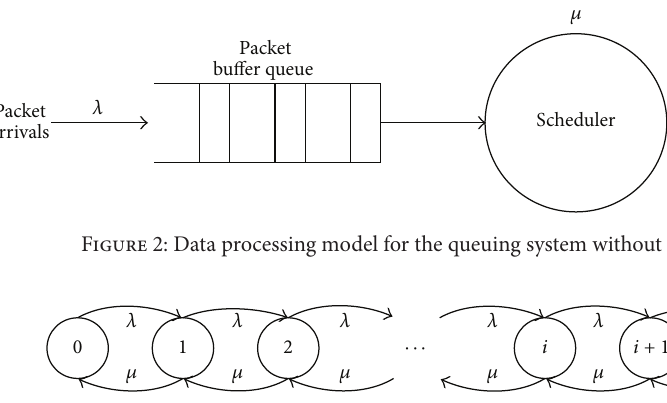
Figure 3: State diagram of birth-death process for queuing system without